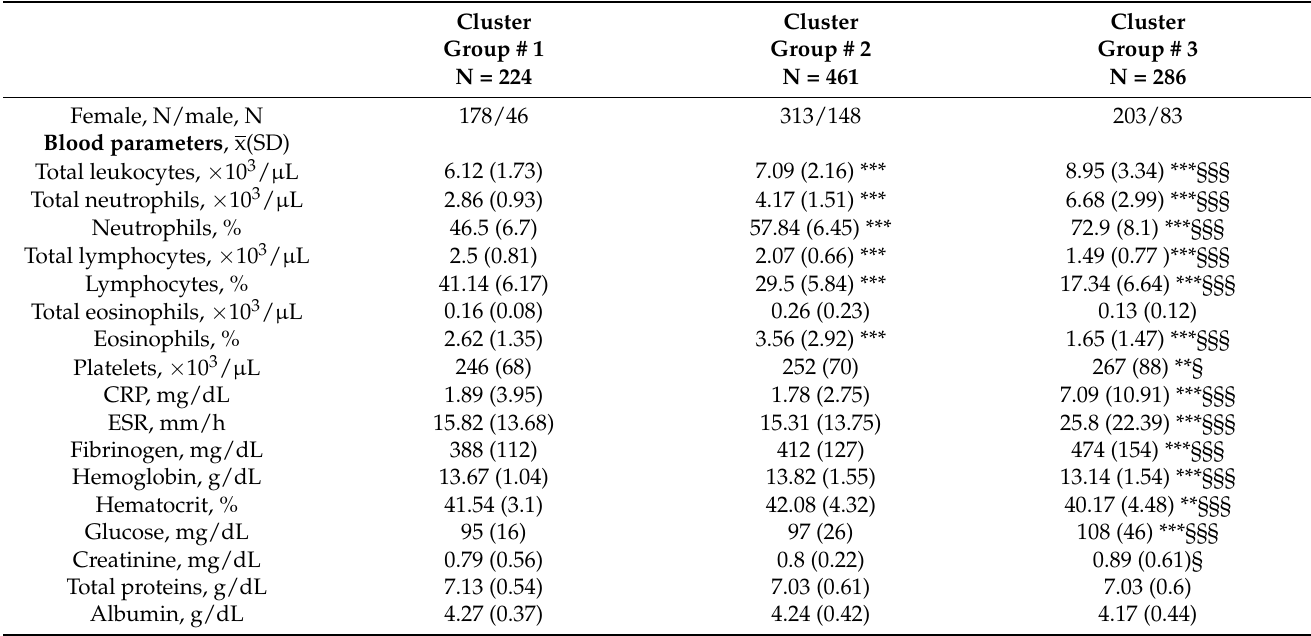
Table 5. Systemic inflammatory and nutritional parameters in the three clusters of patients exclud- ing those with COPD.